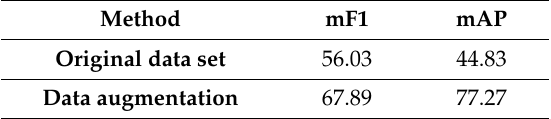
Table 6. Impact of data augmentation using the SSD_CAE method.